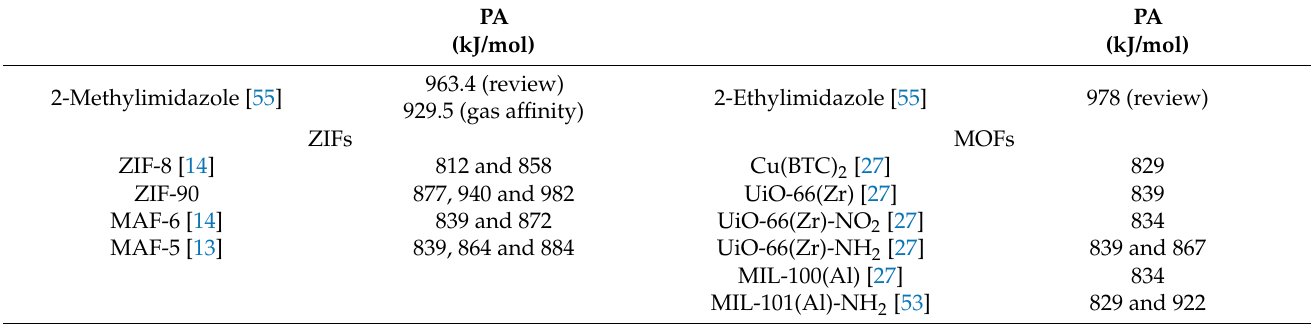
Table 7. The strength of basic sites of Zn-ZIFs according to the DRITF-CDCl 3 method. PA (kJ/mol)